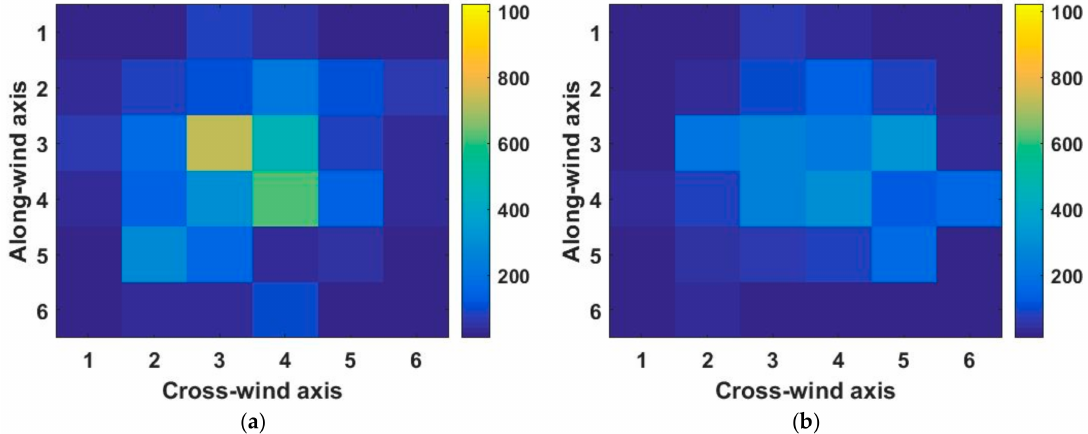
Figure 6. Laser beam as intersected by the optical detector array at two consecutive time steps in the same experimental configuration, θ = 15 ◦ and distance from the fan is 3.5 m. ( a ) Image samples at t = ∆ t ; ( b ) Image sampled at t = ∆ t + 0.05